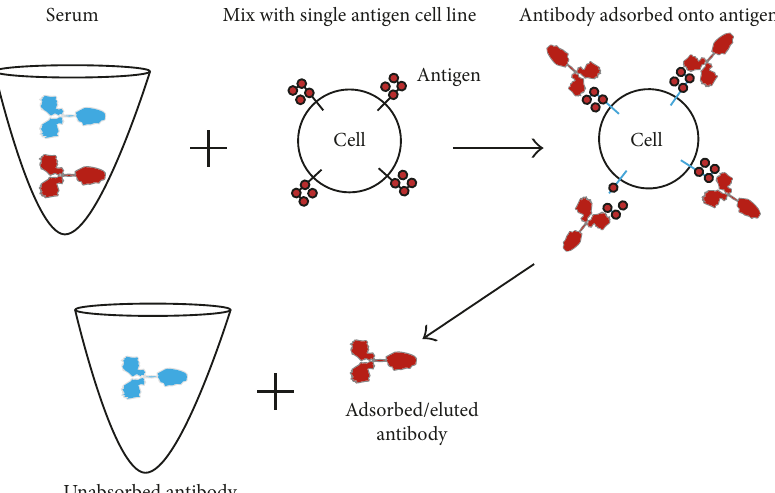
Figure 2: Alloantibody adsorption/elution with recombinant single antigen cell line. The antibody is eluted with an acidic bu ff er, and the eluate is neutralized with TRIS bu ff